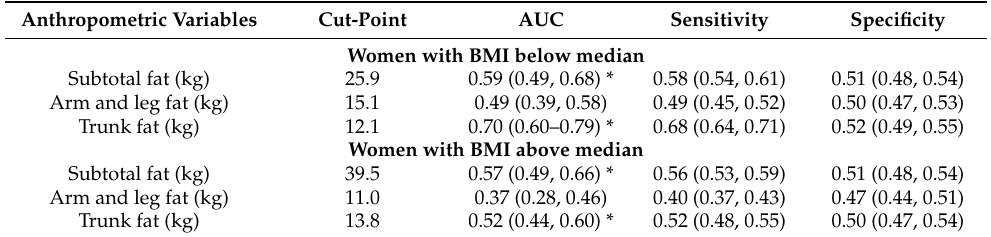
Table 3. Optimal cut-points for detecting MetS (without WC) using DXA-derived anthropometric indices in subjects with BMI below or above median value.